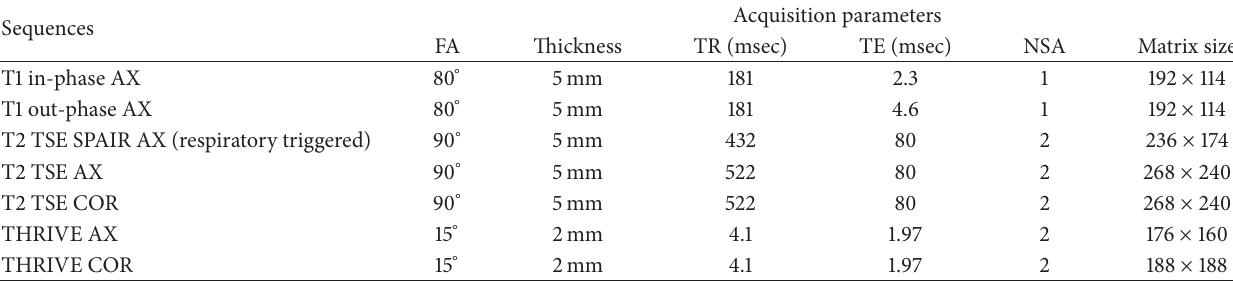
Table 1: Descriptive parameters of acquisition protocol for the study of upper abdomen employed.